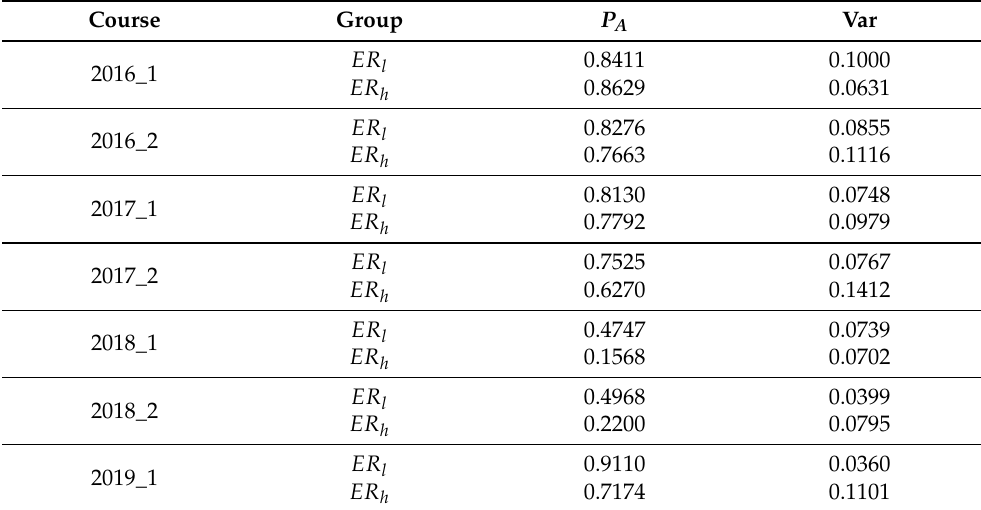
Table 6. Students by risk group and gender.